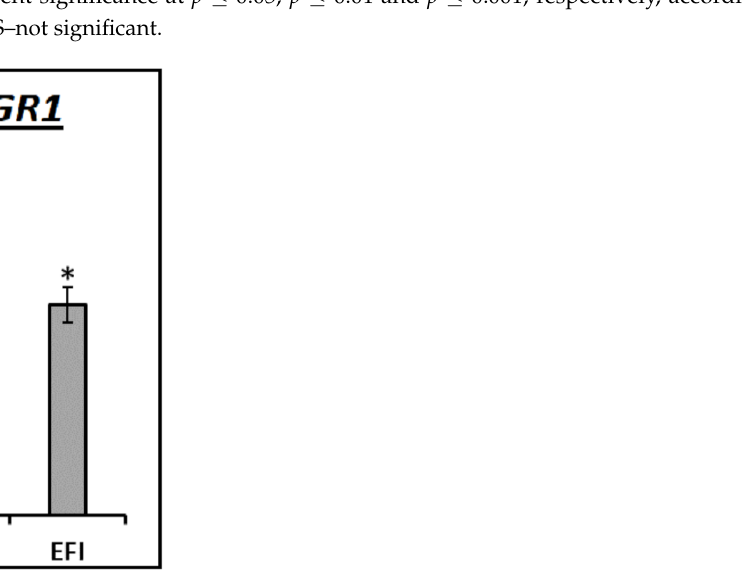
Figure 8. Effect of top sprinkle (TSI) and ebb-and-flow (EFI) irrigation on transcript level of GR gene in tomato root. Vertical bars indicate means ± SE (3 biological and 3 techincal replicates). The * represents significance at p ≤ 0.05, according to Student’s t